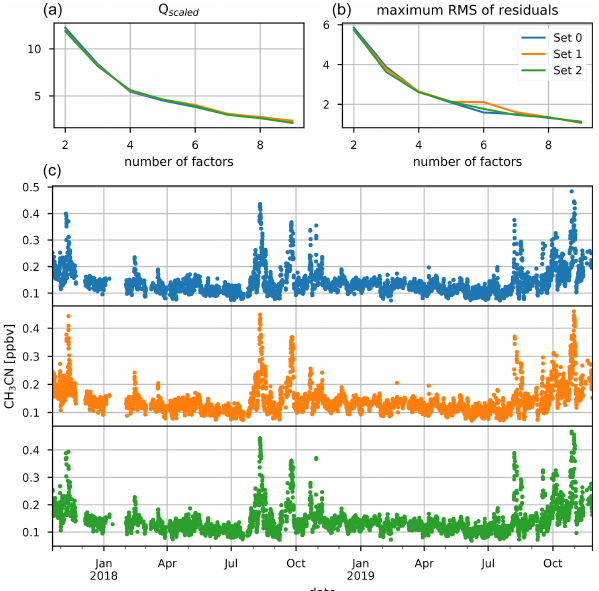
Figure 9. Dataset separation in three different subsets. The top two plots show the scaled objective function (a) and the maximal root mean square (rms) of compound residuals (b) for a scan of the num- ber of factor space from 2 to 9. The bottom three plots (c) show the CH 3 CN mixing ratios (ppbv) for the three different subsets which ensure near-equal occurrence of biomass burning intrusions.